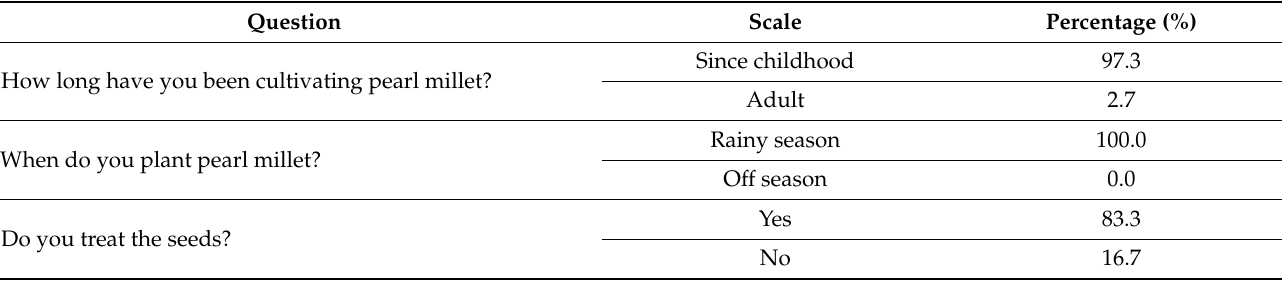
Table 2. Pearl millet farming practices in three departments (Dogondoutchi, Dosso, and Gaya) of the Dosso region in